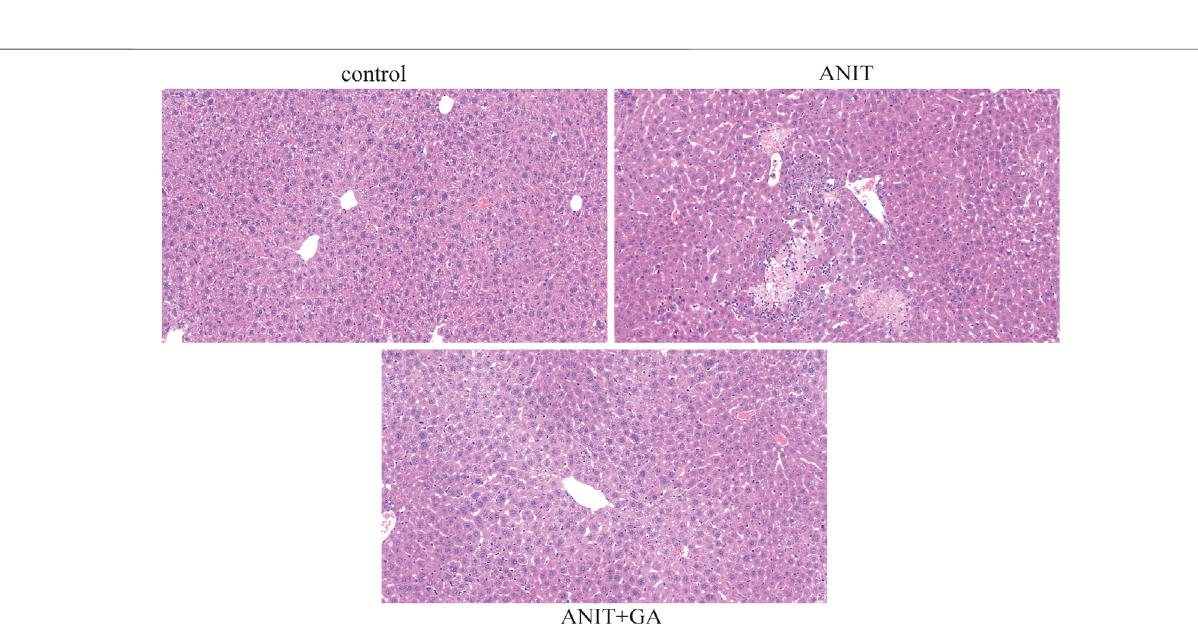
Frontiers in Pharmacology |